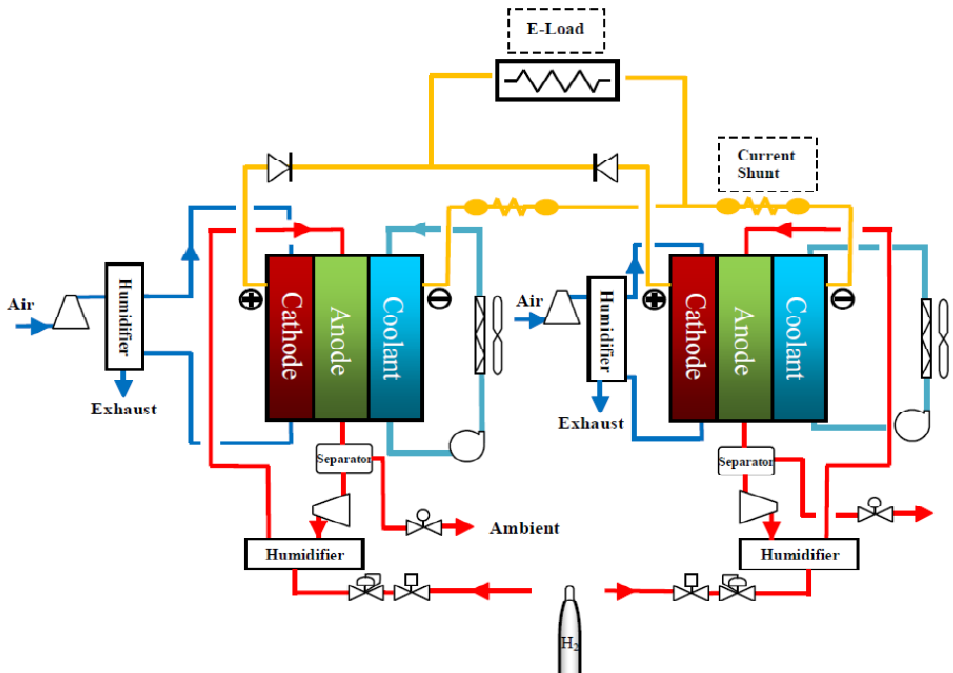
Figure 8. Two fuel cell stacks in electrical parallel configuration.